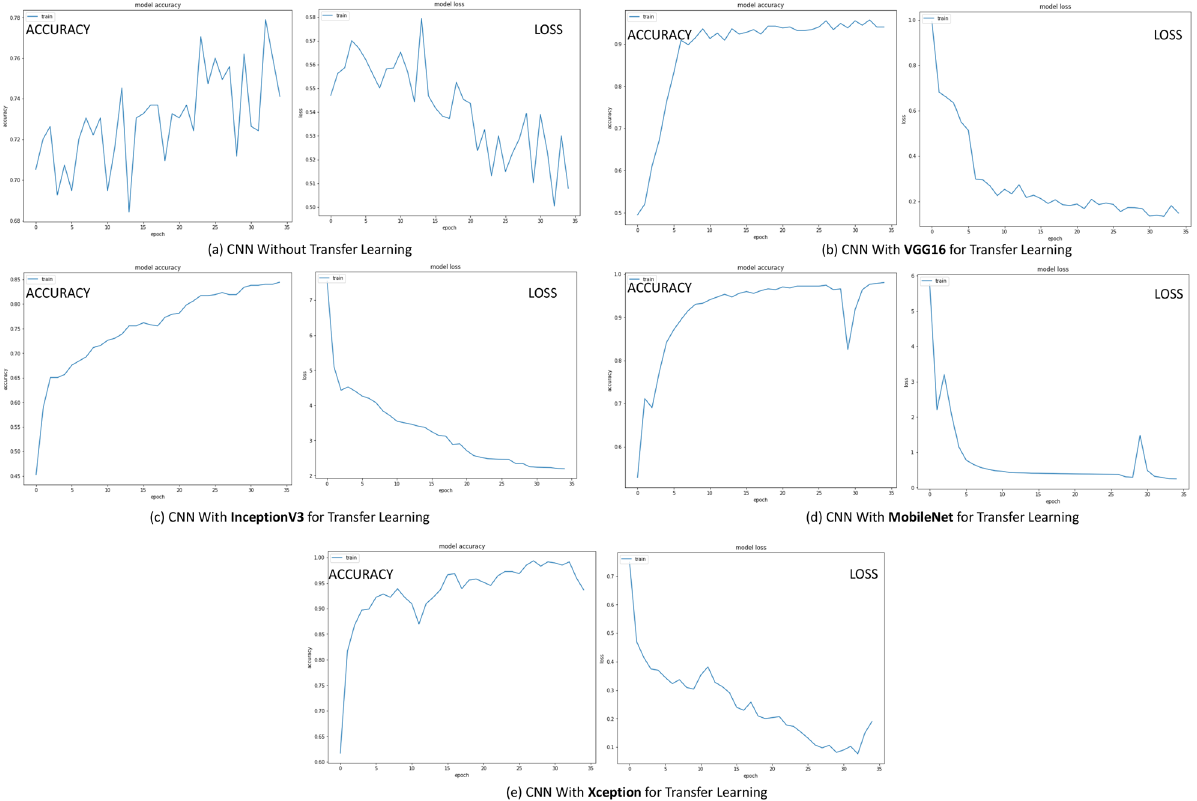
Figure 4. Accuracy and Loss per epoch for DNN models (technique 3) ( a ) CNN without transfer learning ( b ) CNN with VGGNet16 for transfer learning ( c ) with InceptionV3 for transfer learning ( d ) with MobileNet for transfer learning ( e ) with Xception for transfer